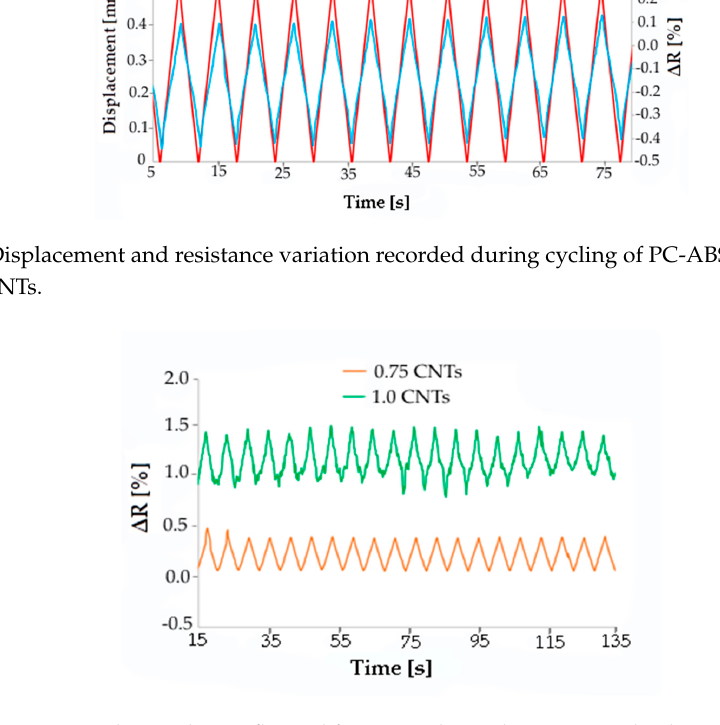
Figure 10. Resistance change during flexural fatigue cycles with maximum displacement of 0.5 mm for PC-ABS composites with 0.75 and 1.0 wt.% CNTs.